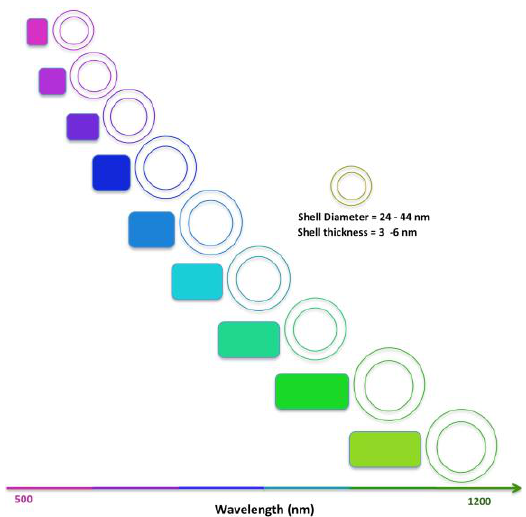
Figure 2. Absorption spectral range of gold nanoshells with varied shell diameter and thickness. Adapted from the data presented in reference [28].